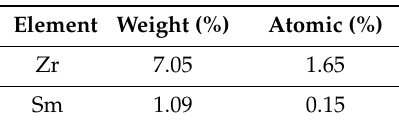
Table 4. Quantitative EDS analysis results obtained from point 2 on the surface of the sample presented in Figure 7 (data only for Zr and Sm).